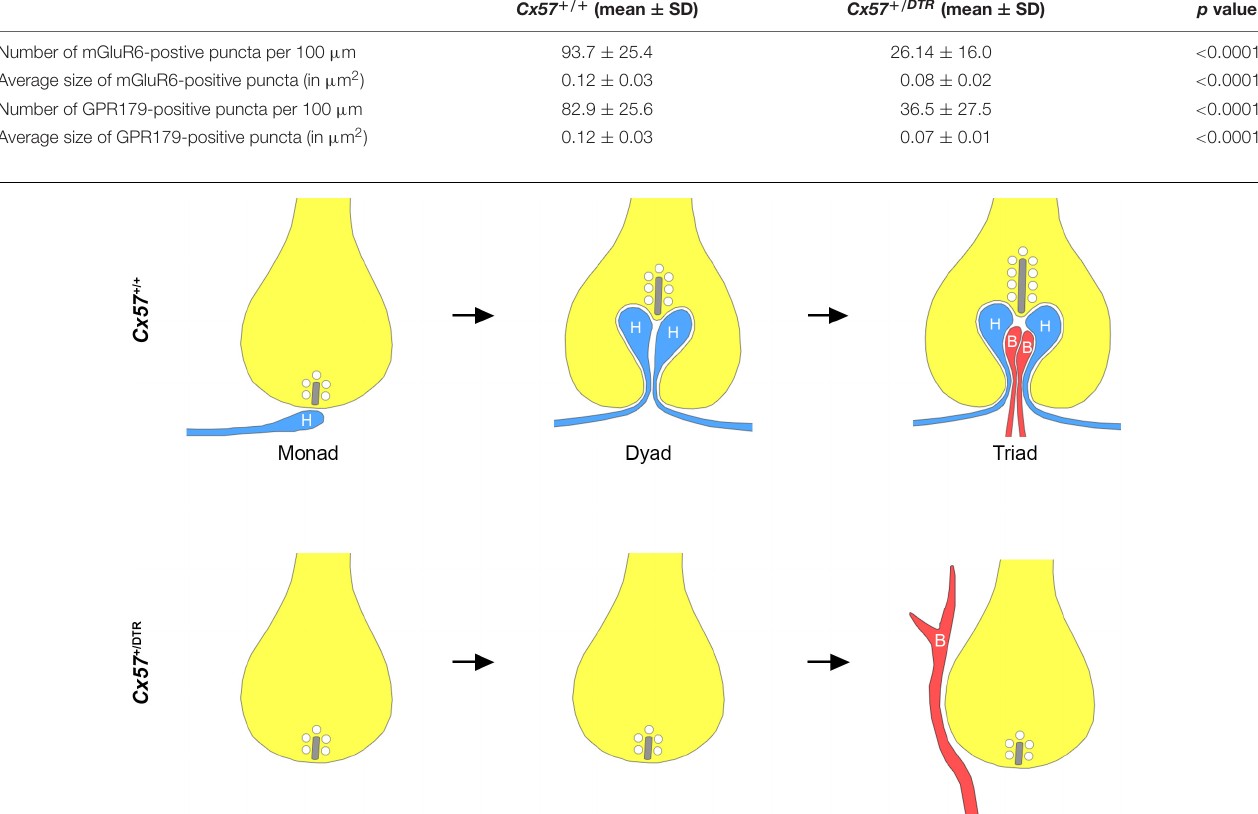
TABLE 2 | Quantification of mGluR6- and GPR179-positive puncta in Cx57 + / + and Cx57 + / DTR mice at P15.